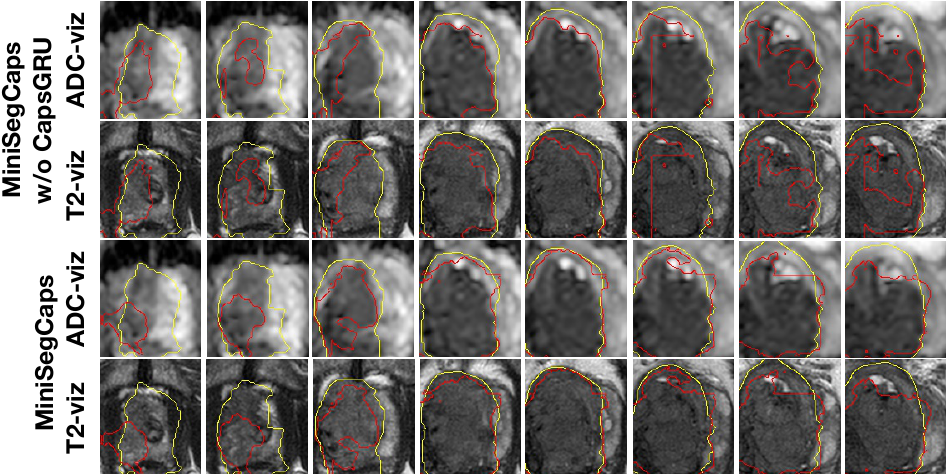
Figure 5. Visualization of lesion segmentation results on eight slices from one case. The yellow contour is ground truth, and the red contours are predictions from the MiniSegCaps without or with CapsGRU. MiniSegCaps with CapsGRU can better delineate the prostate cancer contours across different slices in one case compared to that without CapsGRU.